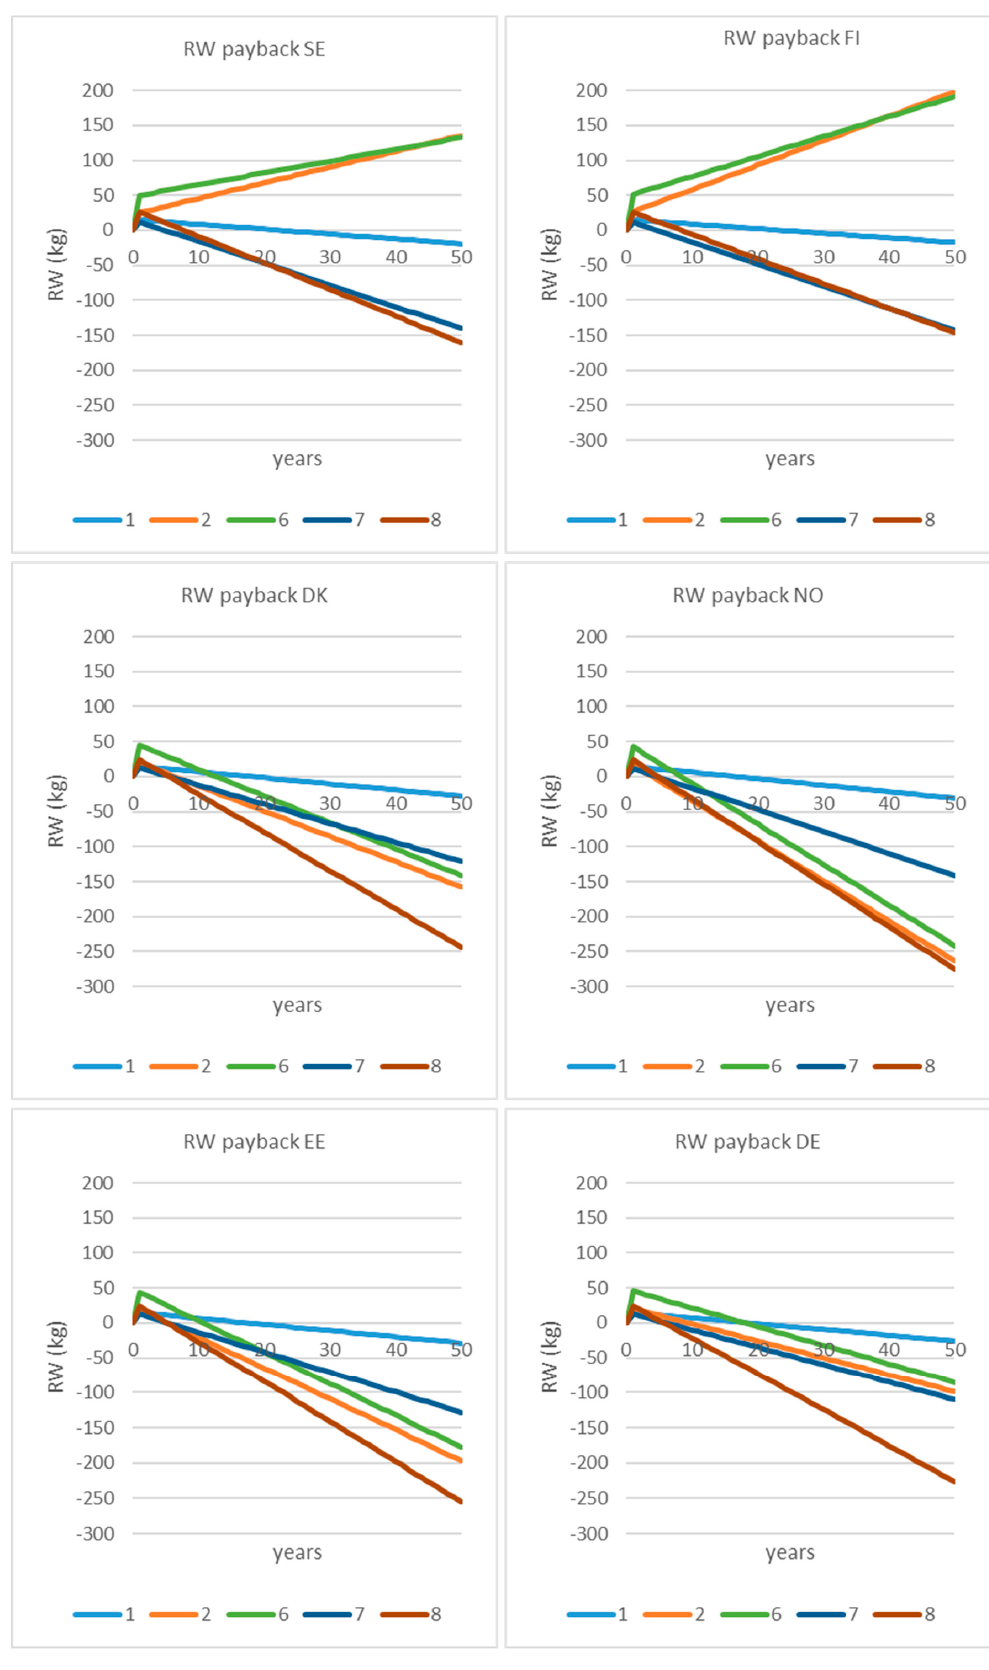
Figure 4. RW Payback of the di ff erent renovation scenarios with di ff erent national electricity